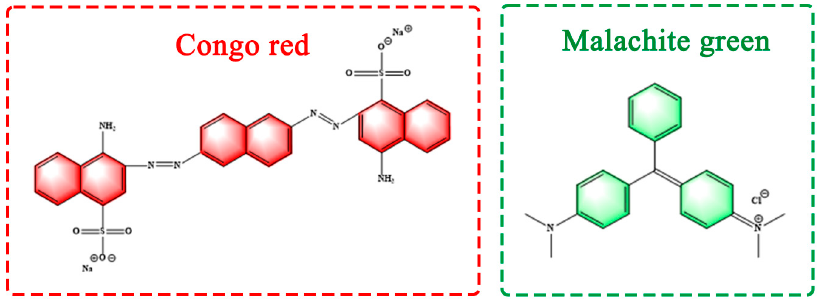
Figure 8. Structural formulae of CR and MG.